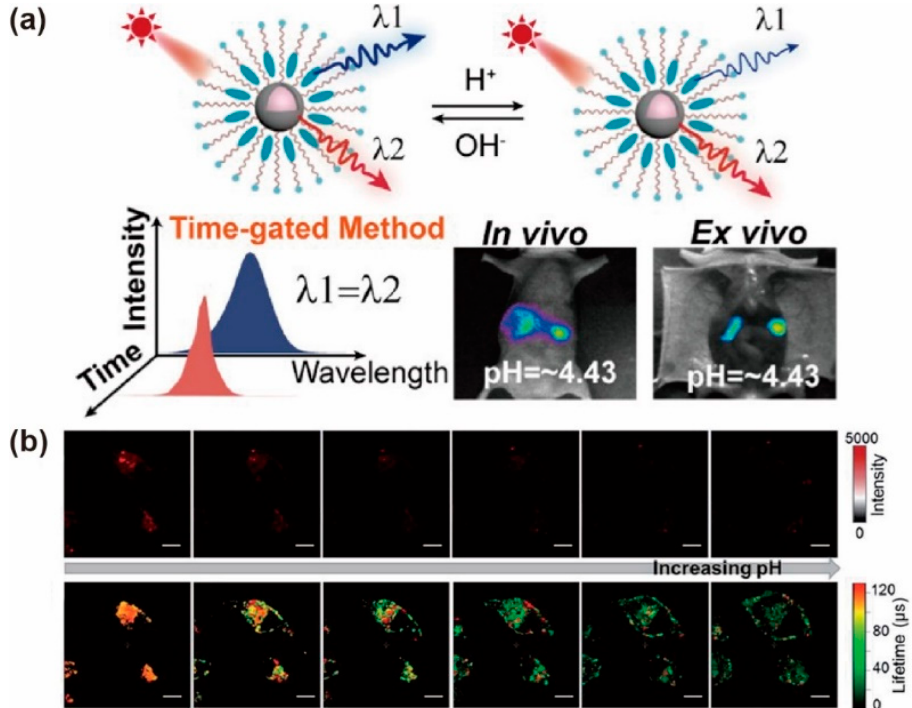
Figure 13. ( a ) The schematic representation and mechanism of the composite probe reversibly re- sponds to variation in the microenvironment and emits two luminescence emissions with different lifetimes. The images of the gastrointestinal area with different pH values in vivo or ex vivo. Re- produced with permission from [93]. Copyright 2020, American Chemical Society. ( b ) The confocal luminescence images (top) and time-resolved luminescence lifetime images (bottom) of F-Yb (10 µ M, 4 h) in HeLa cells reacted with 0.5 µ M chloroquine. Reproduced with permission from [94]. Copyright 2019, Royal Society of Chemistry.